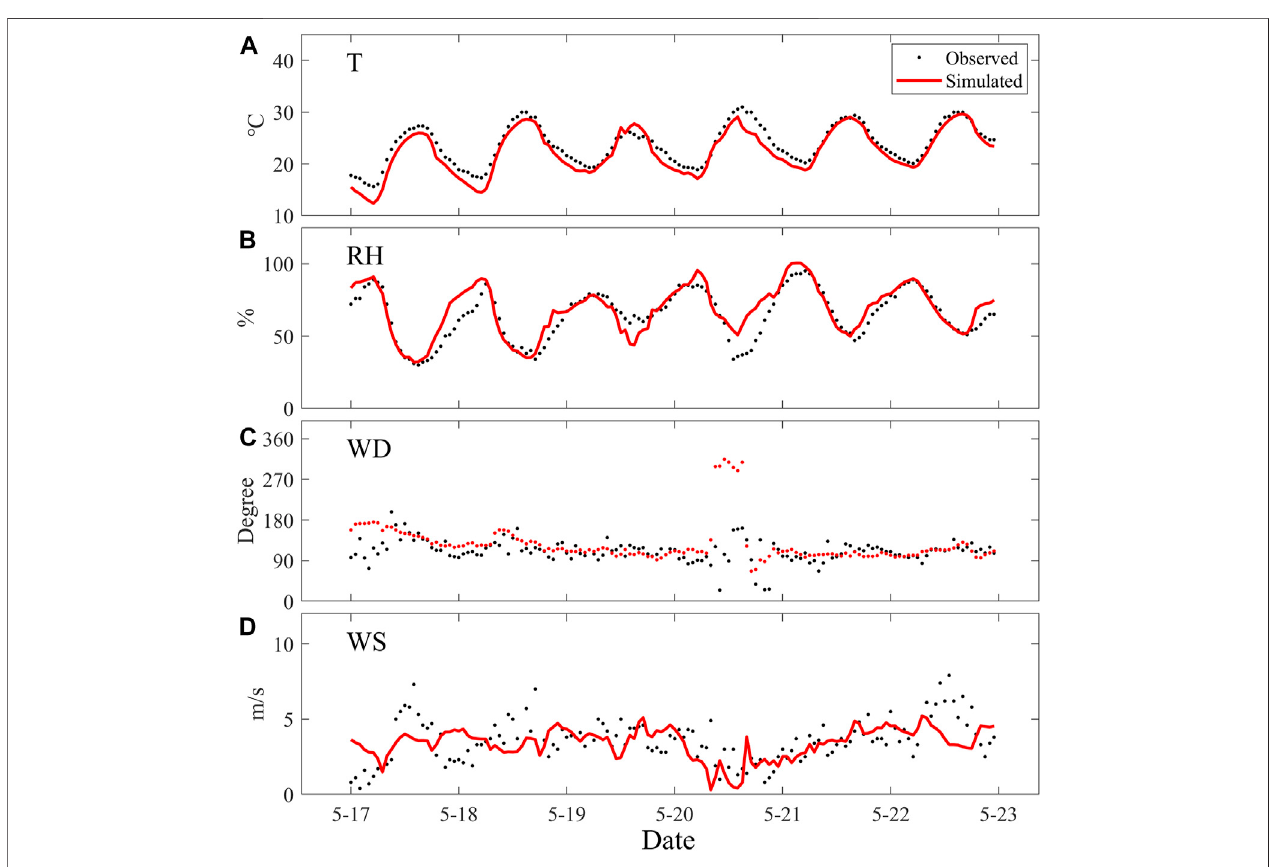
FIGURE 1 | The time series variations of simulated and observed surface meterological parameters, including (A) temperature, (B) relative humidity, (C) wind direction and (D) wind speed (WS), during the study period.